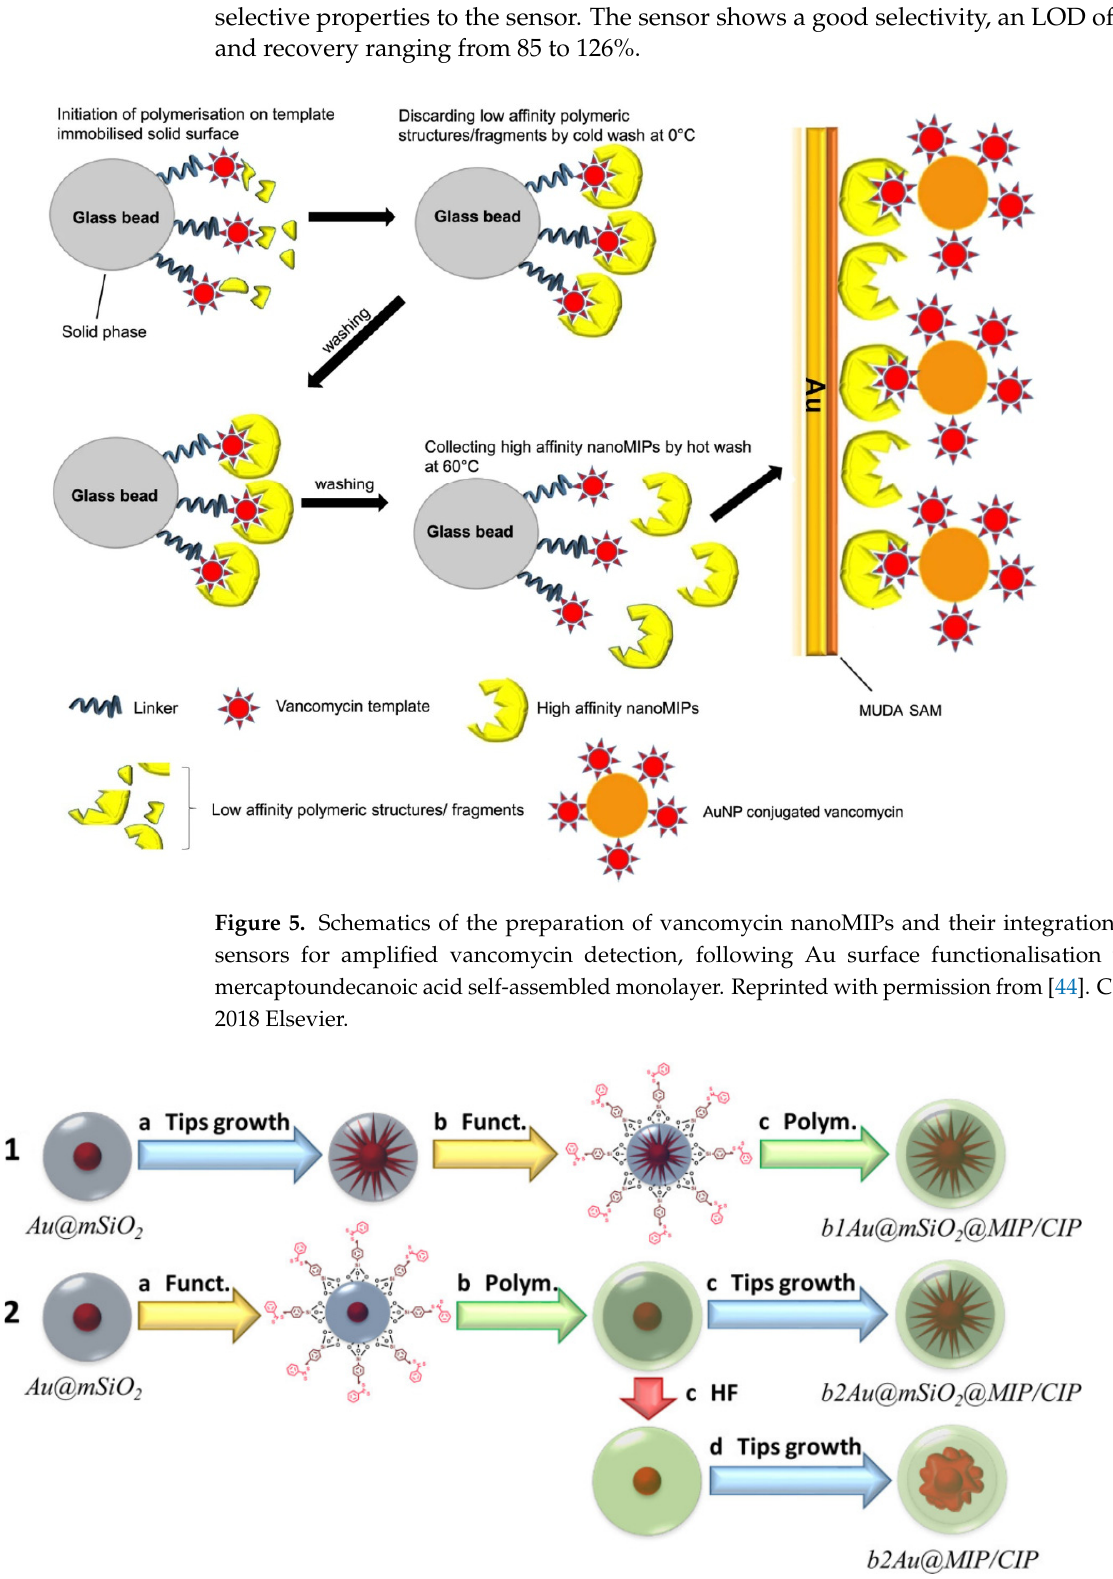
Figure 6. Schematic representation of the different mesoporous nanocomposites fabricated for the development of SERS nanosensors. Reprinted with permission from [97]. Copyright 2022 American Chemical Society.